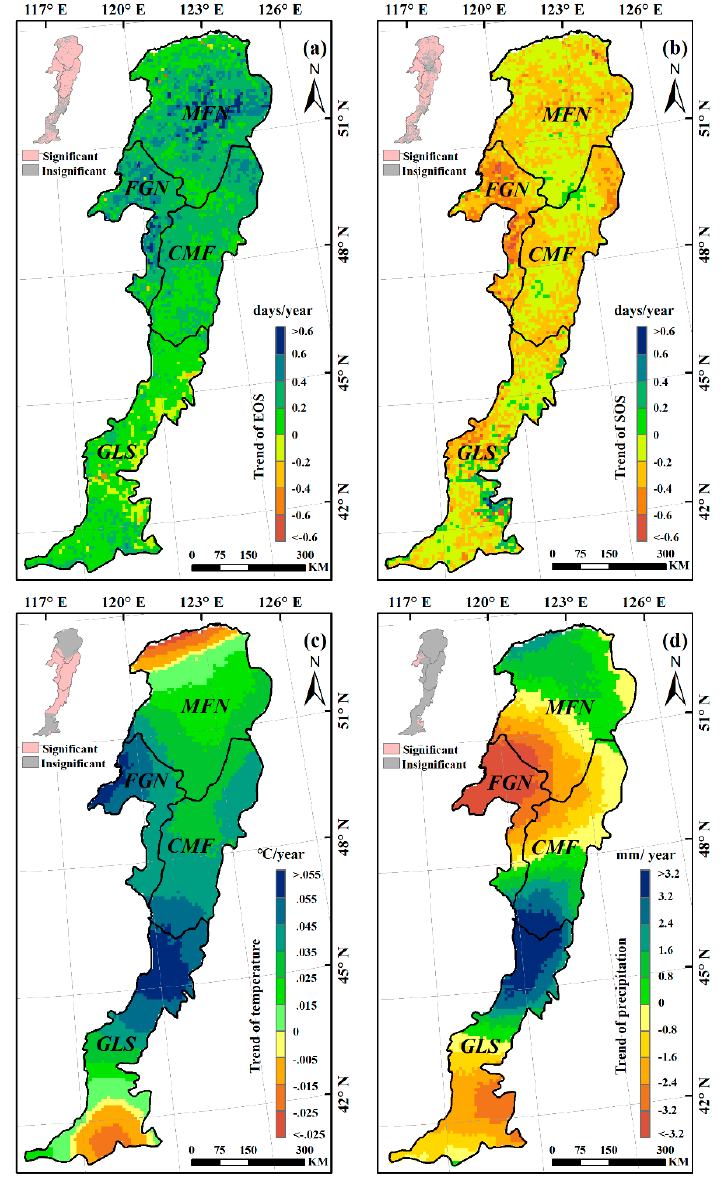
Figure 6. Spatial pattern of interannual temporal trends in EOS ( a ); SOS ( b ); preseason temperature ( c ); and preseason precipitation ( d ) in the Greater Khingan Mountains over 1982–2015. The pink pixels in the top-left inset indicate that the detected trends were significant at p < 0.05.